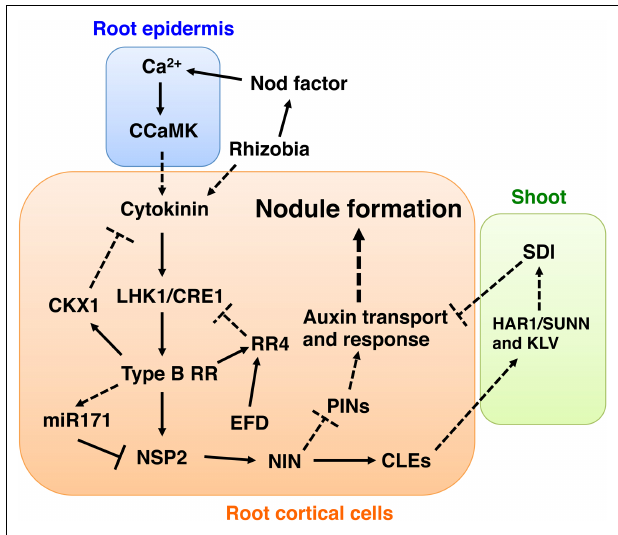
FIGURE 1 | Model depicting auxin- and cytokinin-mediated signaling pathways involved in nodule development. To develop this model, we combined data from studies using L. japonicus and M. truncatula . Based on the observation that NSP2 is required for the induction of NIN (Murakami etal., 2006), we placed NIN downstream of NSP2. Since control of PIN proteins (PINs) localization seems to occur in the downstream part of the cytokinin signaling pathway (Plet etal., 2011) and NIN has an ability to induce localized auxin responses (Suzaki etal., 2012), we suggest that the site of PINs regulation is downstream of NIN. A putative shoot-derived inhibitor (SDI) is proposed as a negative regulatory signal of nodule development mediated by the AON mechanism involving HAR1/SUNN, KLV, and nodulation-related CLE peptides (CLEs) (Ferguson etal., 2010; Kouchi etal., 2010). Here, we suggest that SDI might inhibit cytokinin and auxin actions. Proven and putative regulation points are indicated by intact lines and dotted lines, respectively. See text for more detailed explanations of the